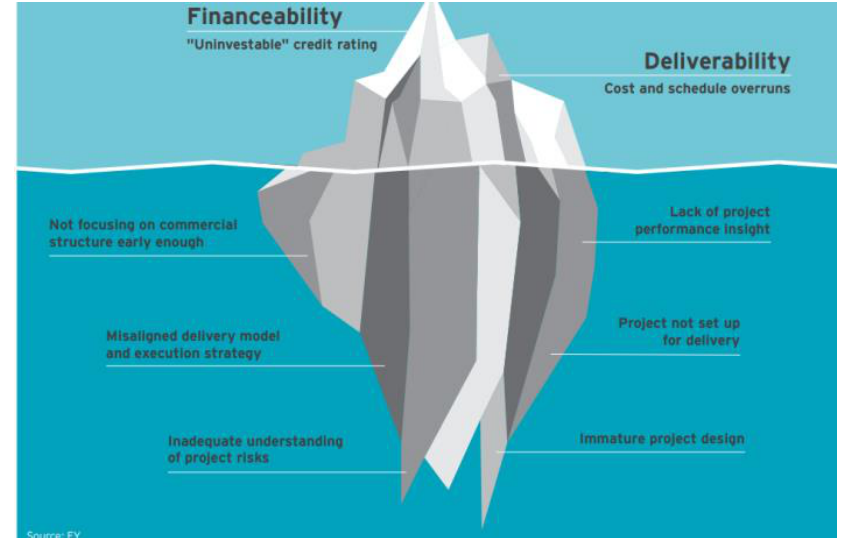
Figure 1. The challenges of the MCPs “Source: Authors based on literature